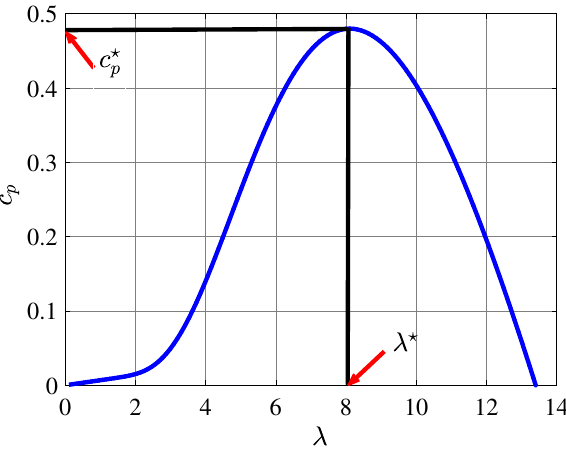
Figure 3. Curve of the power coefficient c p at β =